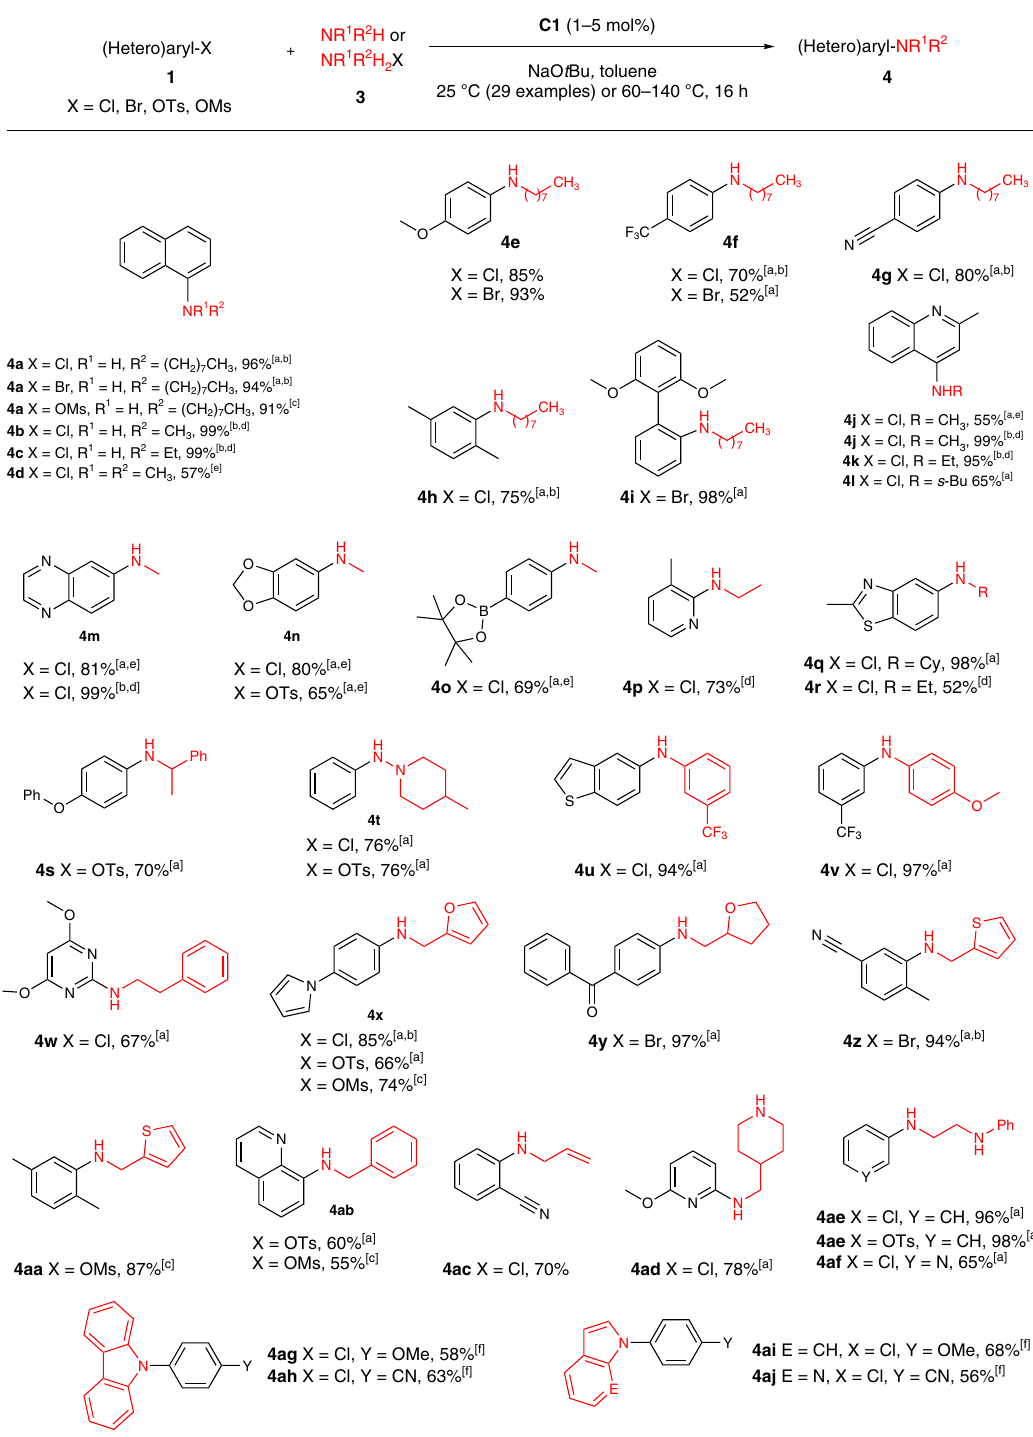
Figure 7 | Scope of amine monoarylation using C1. Unless stated otherwise, reactions were conducted employing C1 (1–5mol%), NaO t Bu (1.5equiv), amine (1.1equiv), in toluene for 16h (unoptimized), with yields of isolated products reported; throughout, see the Supplementary Information for complete experimental details. [a] 25 (cid:2) C. [b] 1mol% C1 . [c] K 3 PO 4 (6equiv) used as base, in CPME at 110 (cid:2) C. [d] 110–140 (cid:2) C for 5–30min under microwave conditions using NaO t Bu (6.5equiv) and MeNH 3 Cl or EtNH 3 Cl (5equiv) in CPME. [e] 3–7equiv amine. [f] 10mol% C1 , NaO t Bu (3equiv), amine (1equiv) in 1,4-dioxane at 110 (cid:2) C.